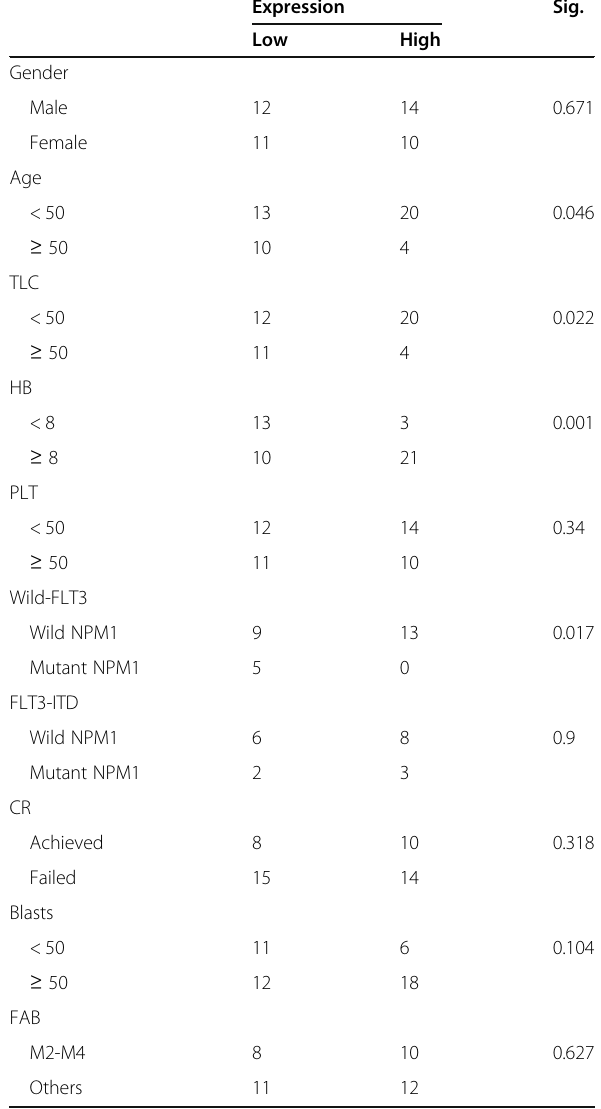
Table 3 Correlation of HOTAIR gene expression to AML patient ’ s clinicopathological parameters